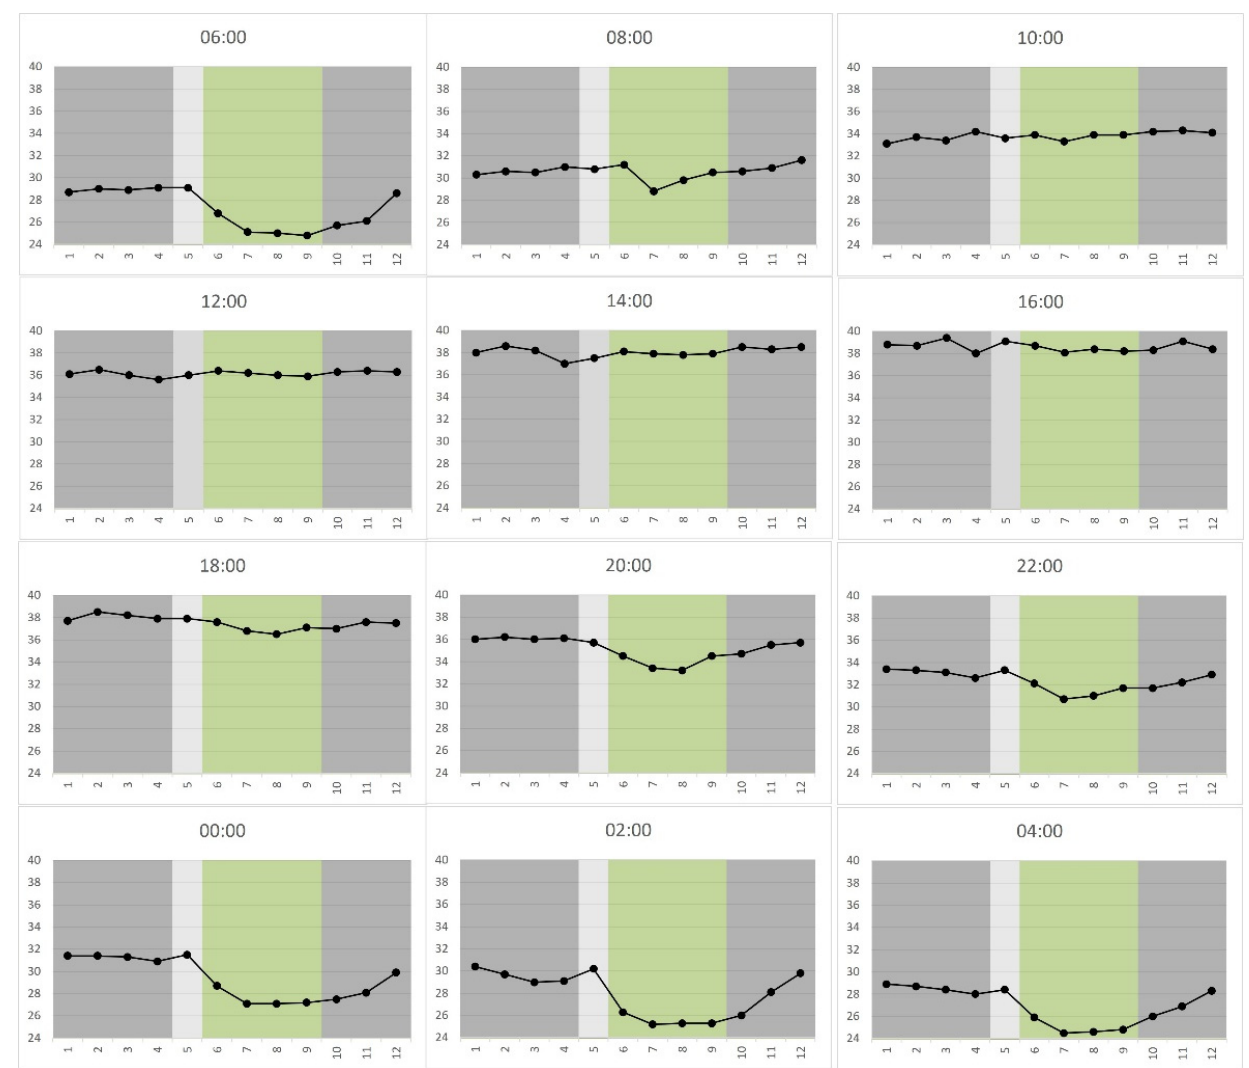
Figure 4. Transect 1—charts of single-lap measurements. LCZs are represented with different background colours: 2—dark grey; 9—light grey; B—green; Y axis reports air temperatures in °C.